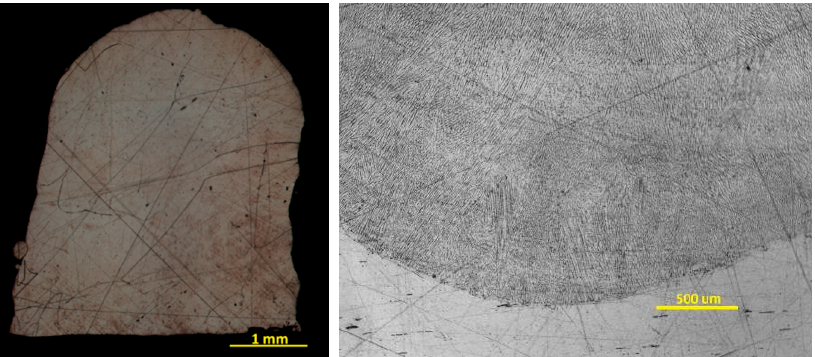
Figure 6. Micrograph of cross sections of a wall and a detail of bonding zone.